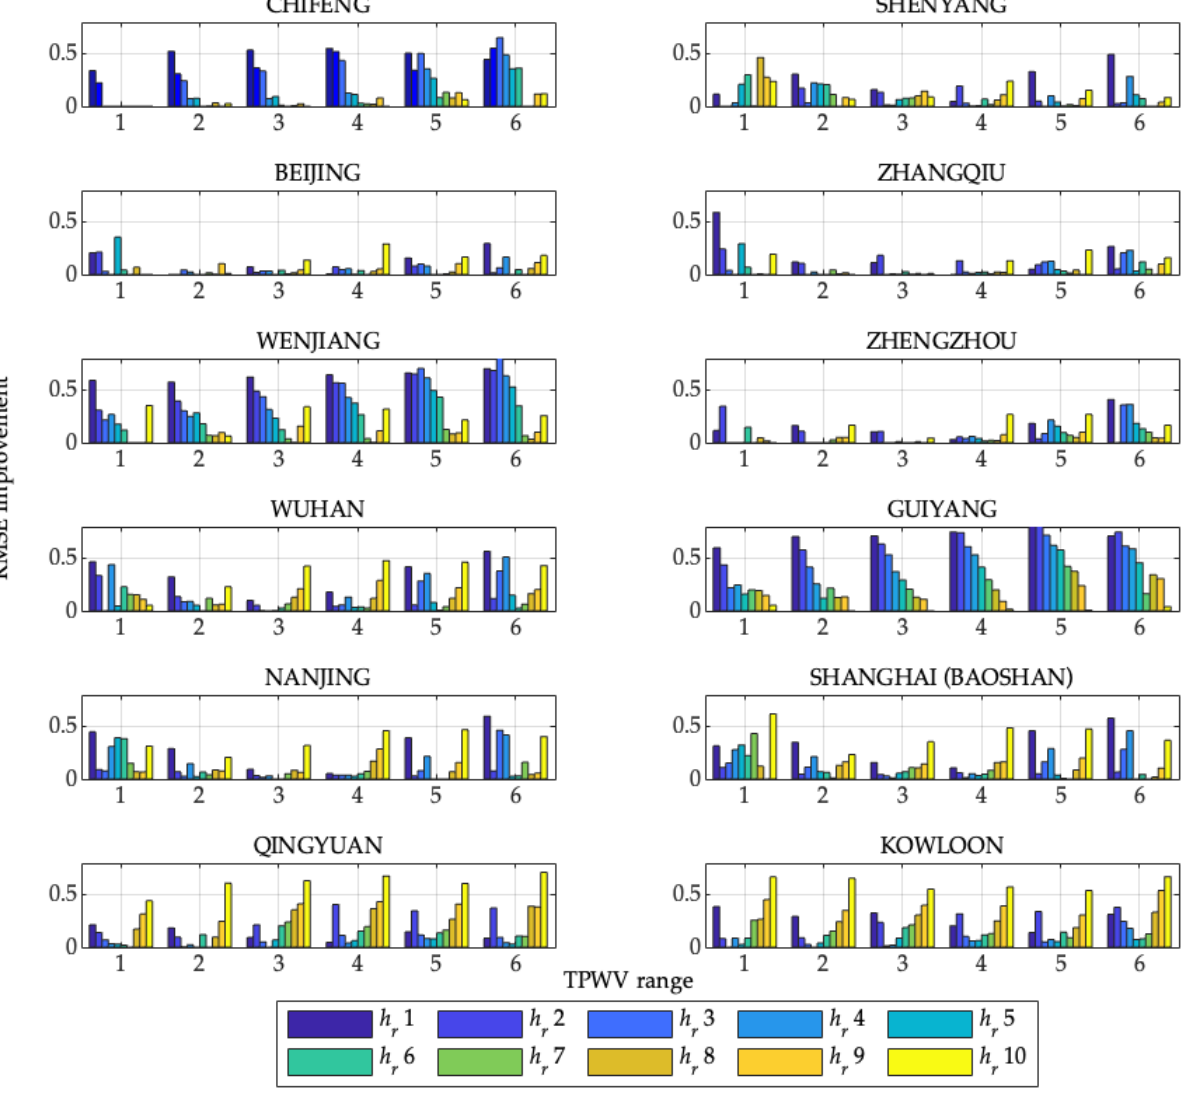
Figure 7. Improvement ratio of annual RMSE of ρ wm resulting from the new model and TPWV relative to that of ρ wH in each of 10 height ranges within each of six TPWV r at each of the 12 sta- tions.